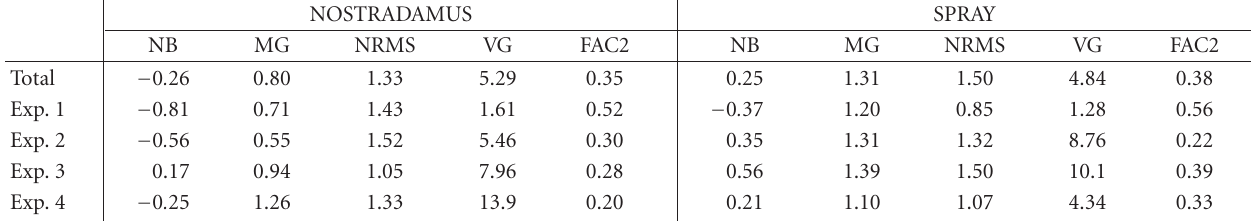
Table 5: Statistical criteria with the spatial averaging (by arc with time fixed).